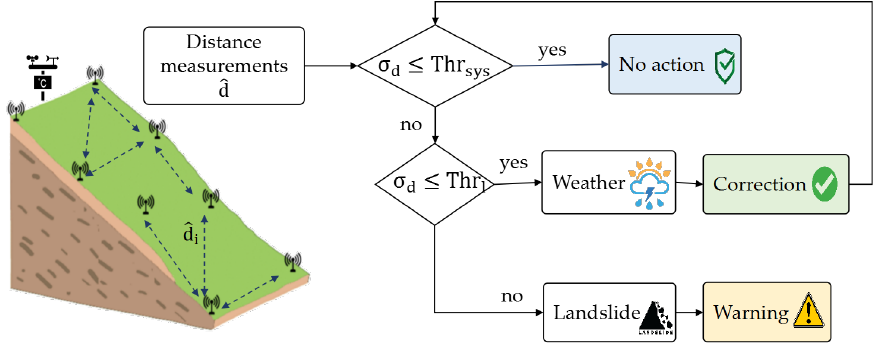
Figure 12. Schematic representation of the landslide early warning